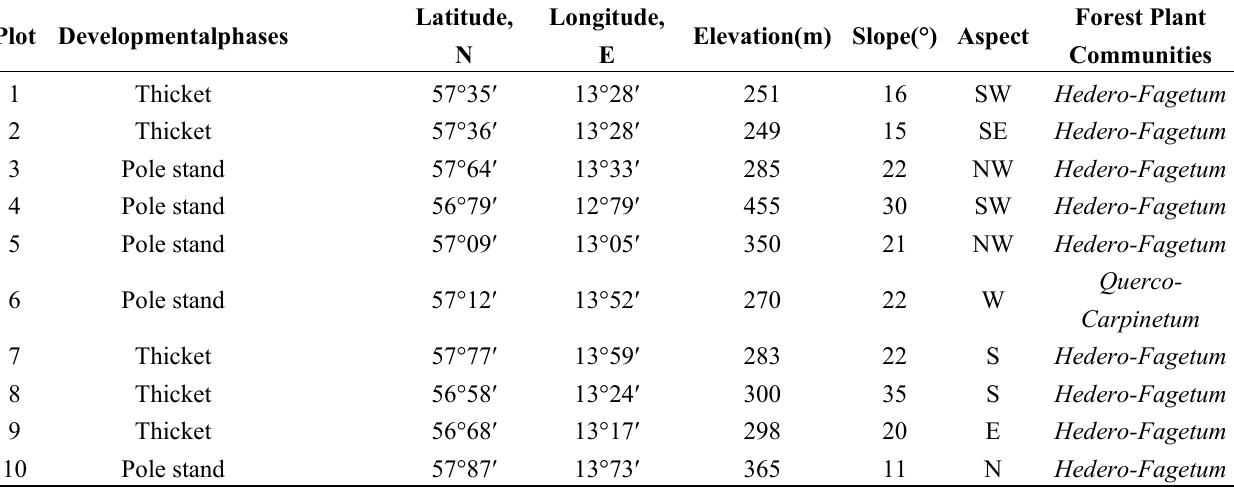
Table A1. General site and stand data of Tending plots. The sampling area was 400 m 2